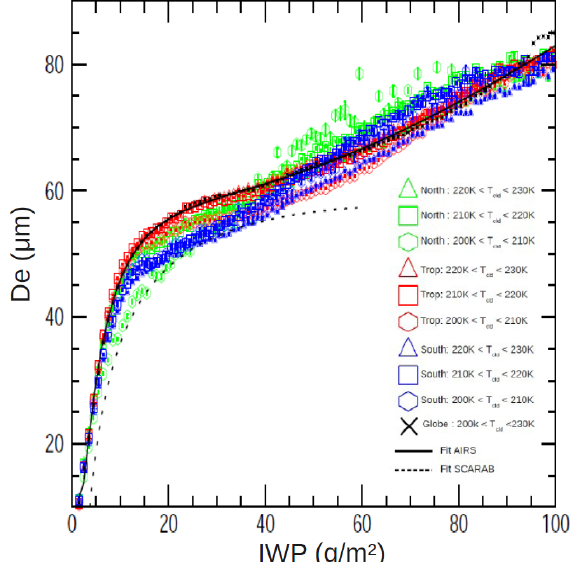
Fig.15. Relationshipbetween D e andIWP,asretrievedfromAIRSobservationsforST-HICs. Resultsareshownforthreelatitudebands, Fig. 15. Relationship between D e and IWP, as retrieved from AIRS separatelyforthreetemperatureintervals. Theglobalannualdependenceisalsoshown(blackcross),aswellastheparameterizationofEq. observations for ST-HICs. Results are shown for three latitude 4(blackline).Statisticsisovertheperiod2003-2009. bands, separately for three temperature intervals. The global annual dependence is also shown (black cross), as well as the parameteriza- tion of Eq. (4) (black line). Statistics is over the period 2003–2009.